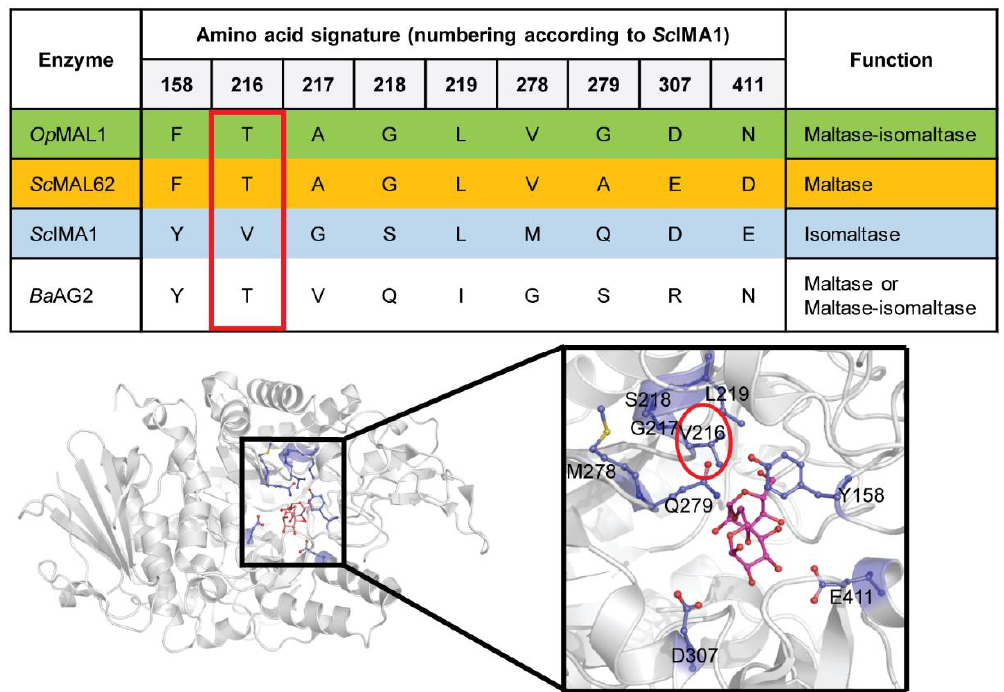
Figure 1. Amino acid signature of yeast α -glucosidases, including B. adeninivorans AG2 (upper panel) and their designation on the three-dimensional (3D) structure of S. cerevisiae isomaltase IMA1 in complex with isomaltose (RCSB Protein Data Bank, PDB: 3AXH [29]) (lower panel). Location of Val216 in the structure is marked with a red circle.